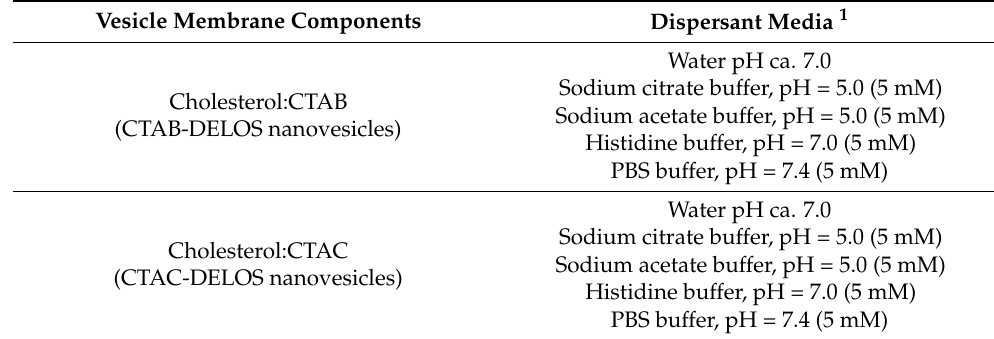
Table 1. Overview of the membrane components and dispersant media tested in the DELOS nanovesi- cles formulations under